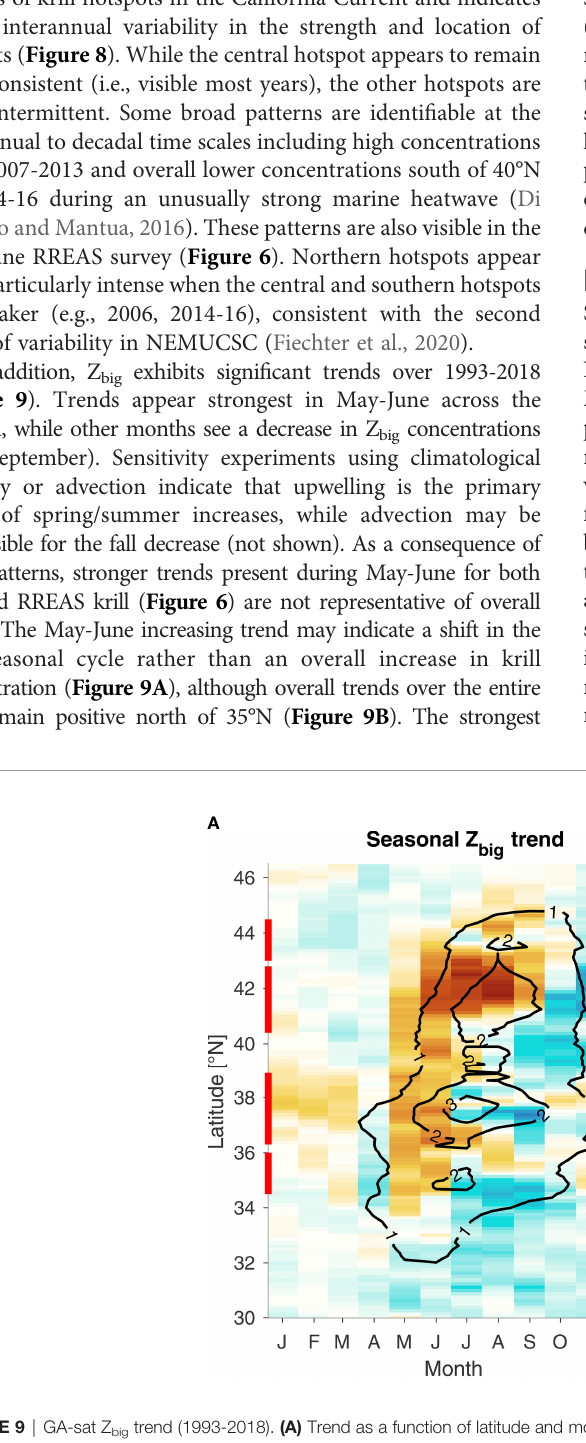
FIGURE 9 | GA-sat Z big trend (1993-2018). (A) Trend as a function of latitude and month of the year (colors); black contours display the Z big seasonal cycle (mmolC m -3 ). (B) Overall trend calculated at each latitude. Red bars indicate the hotspot